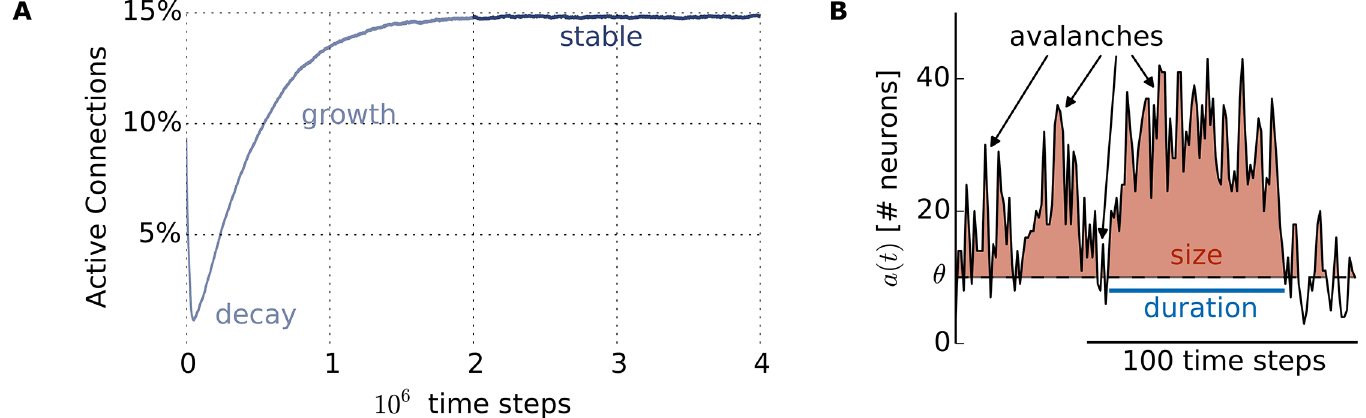
Fig 1. SORN regimes and neuronal avalanches. (A) Fraction of active connections in the SORN, starting from a random connected graph with 0.1 active connections. It exhibits three self-organization phases: decay , growth , and stable . (B) Activity threshold θ for a typical snapshotof SORN activity a ( t ) (150 time steps). Avalanche durationis indicatedin blue and avalanchesize in shadedred. The neuronalavalanches were measuredonly duringthe stable phase.